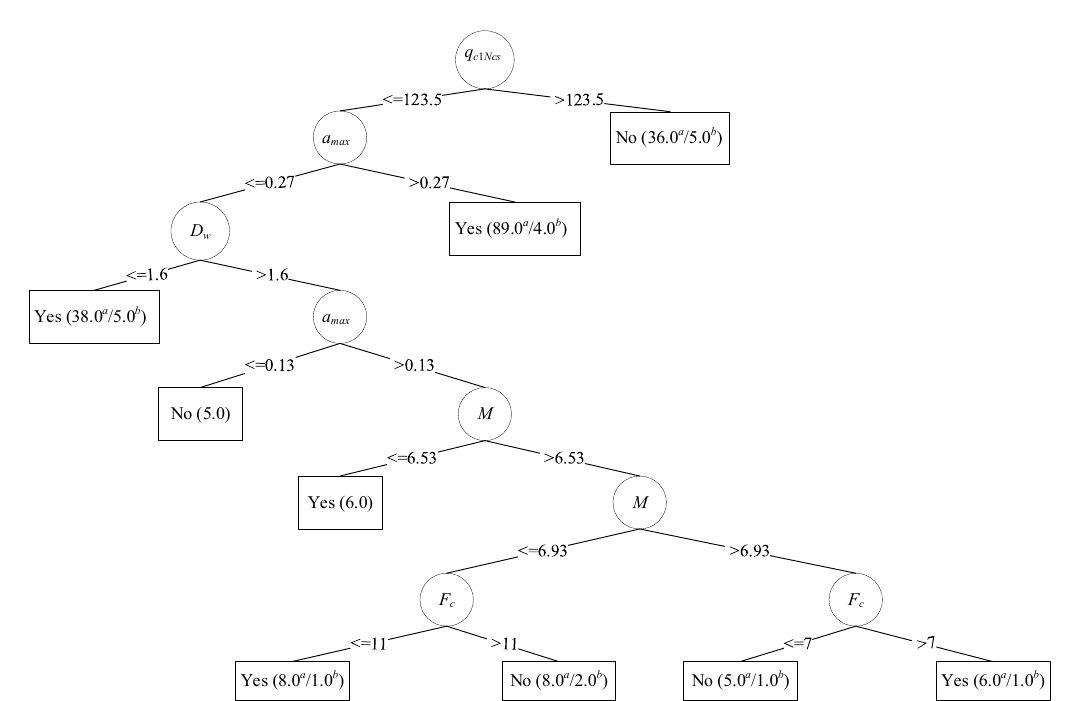
Figure 4. Decision tree of seismic soil liquefaction generated by a C4.5 algorithm. a Number of cases in this partition; b Number of cases misclassified.